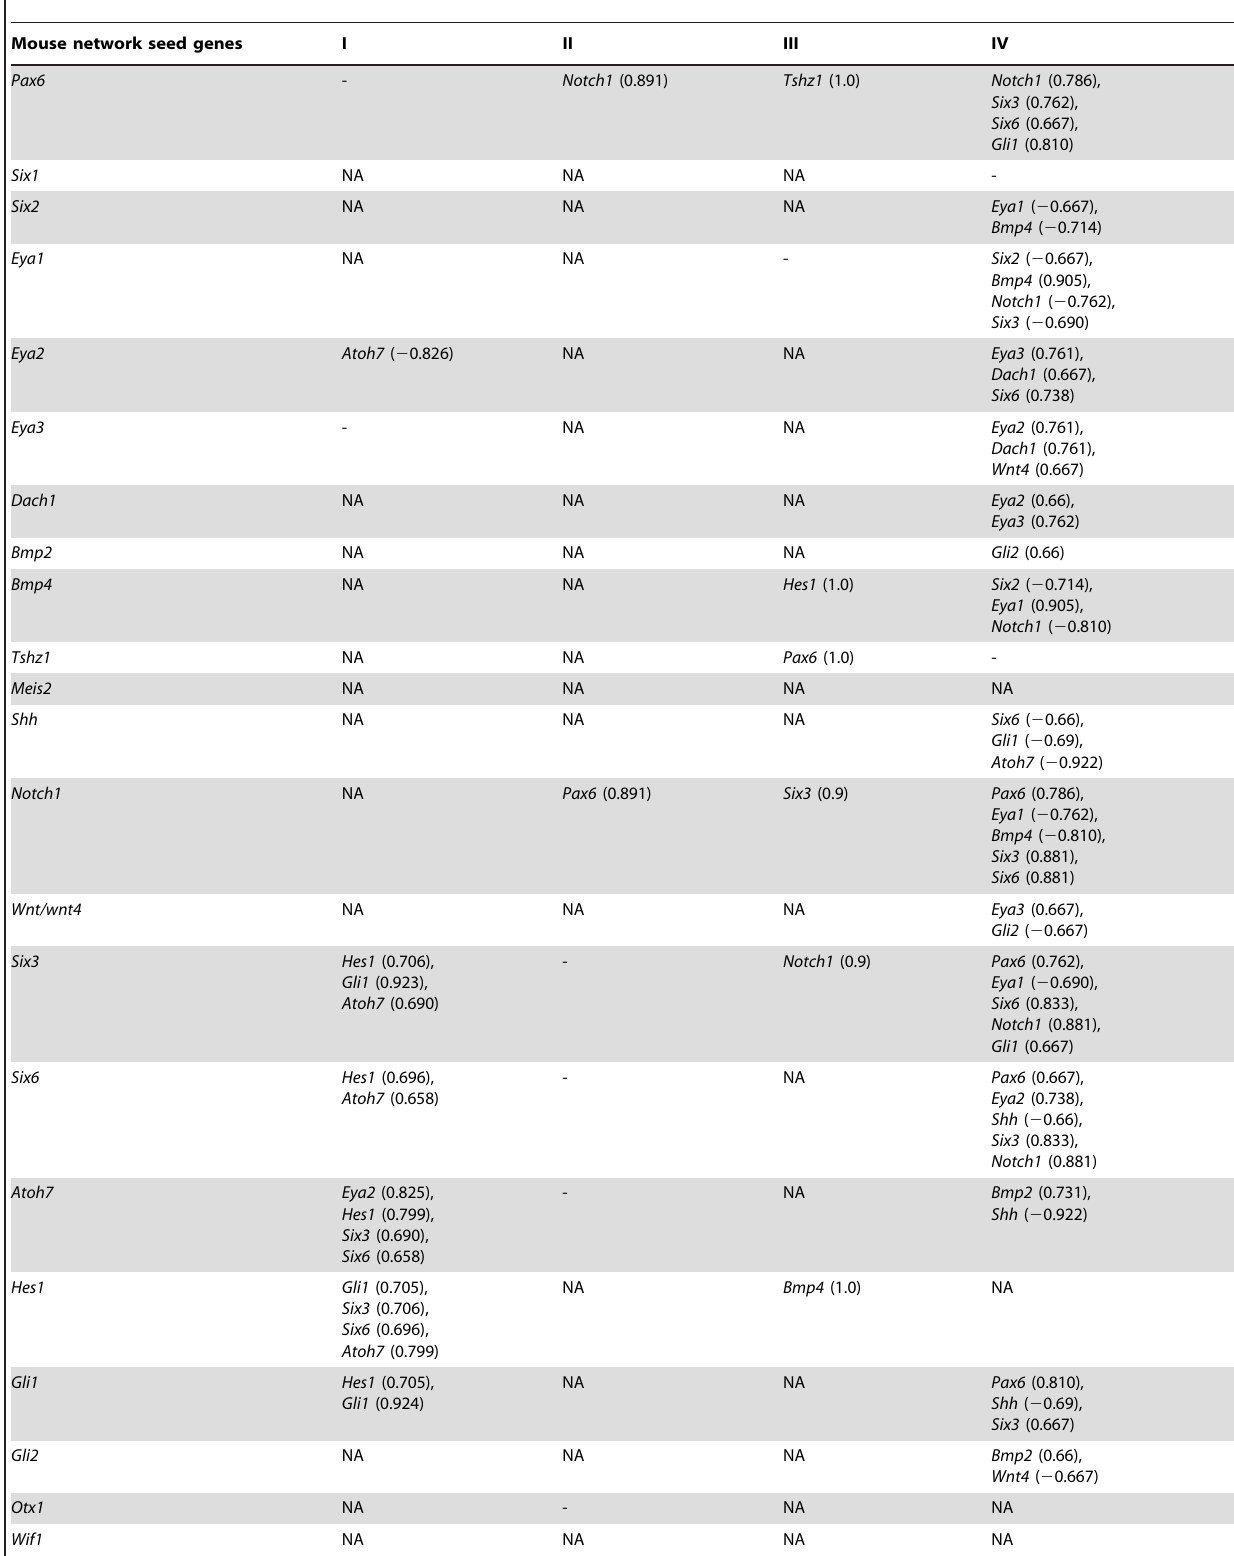
Table 2. Correlation of network seed genes in each of the four expression datasets of mouse.